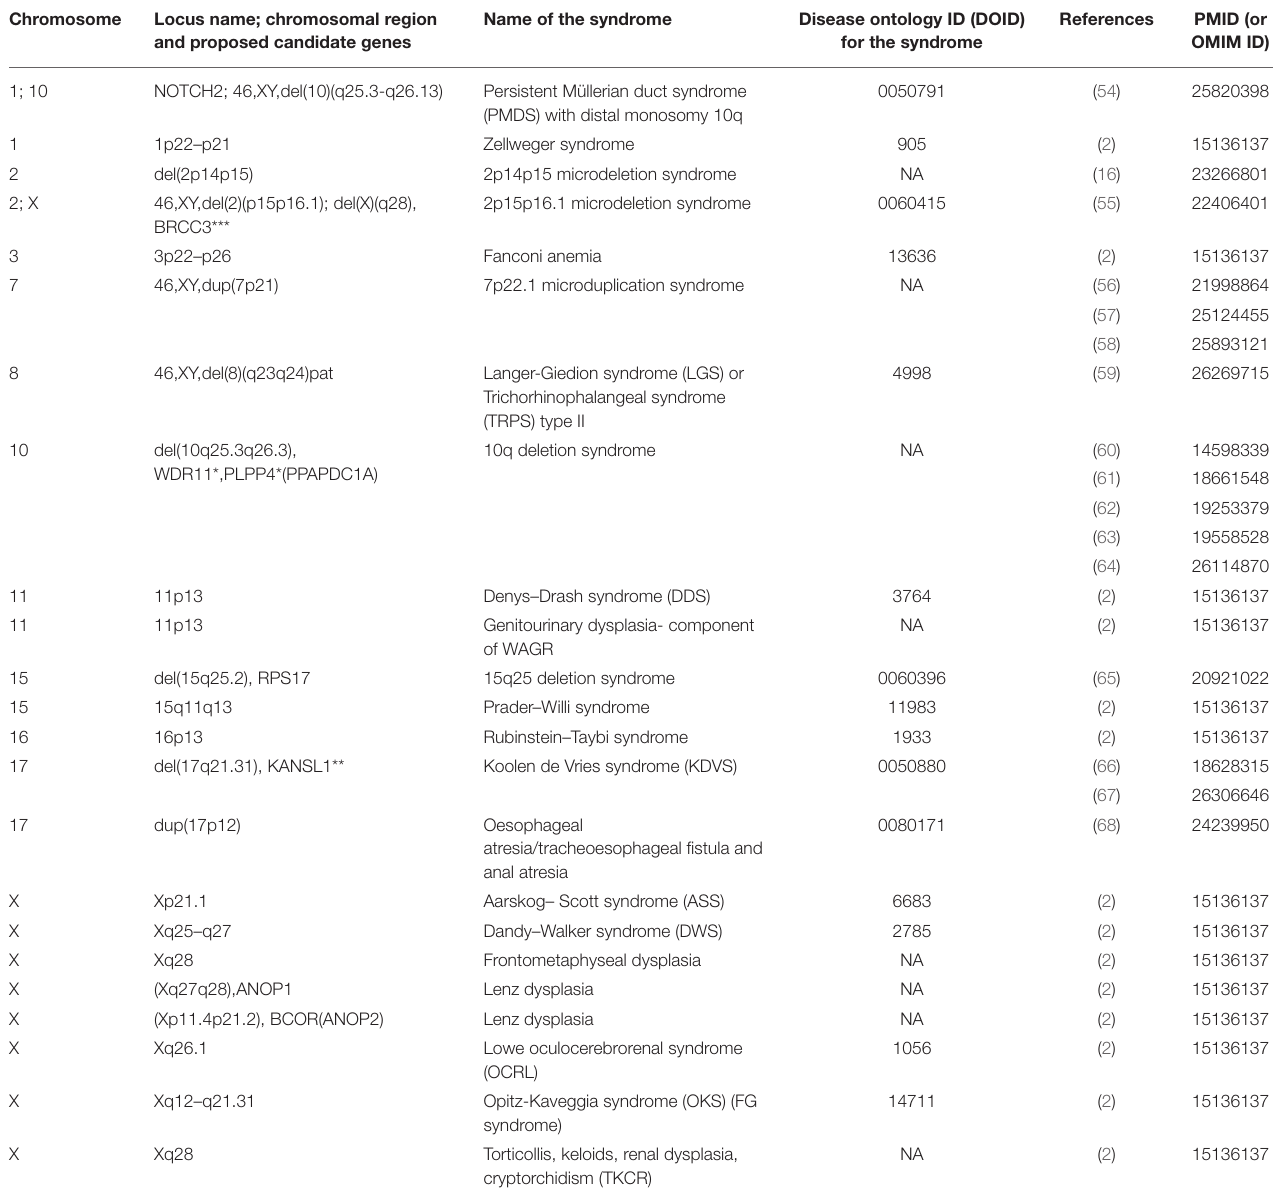
TABLE 2 | Chromosomal regions, associated with syndromes with cryptorchidism in clinical picture.